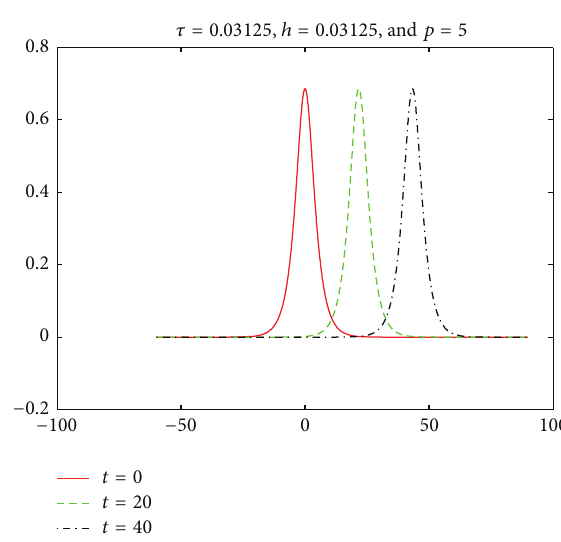
Figure 4: Wave graph of 𝑢 (𝑥,𝑡) at various times when 𝑝 = 5 and 𝜏 = ℎ = 0.03125